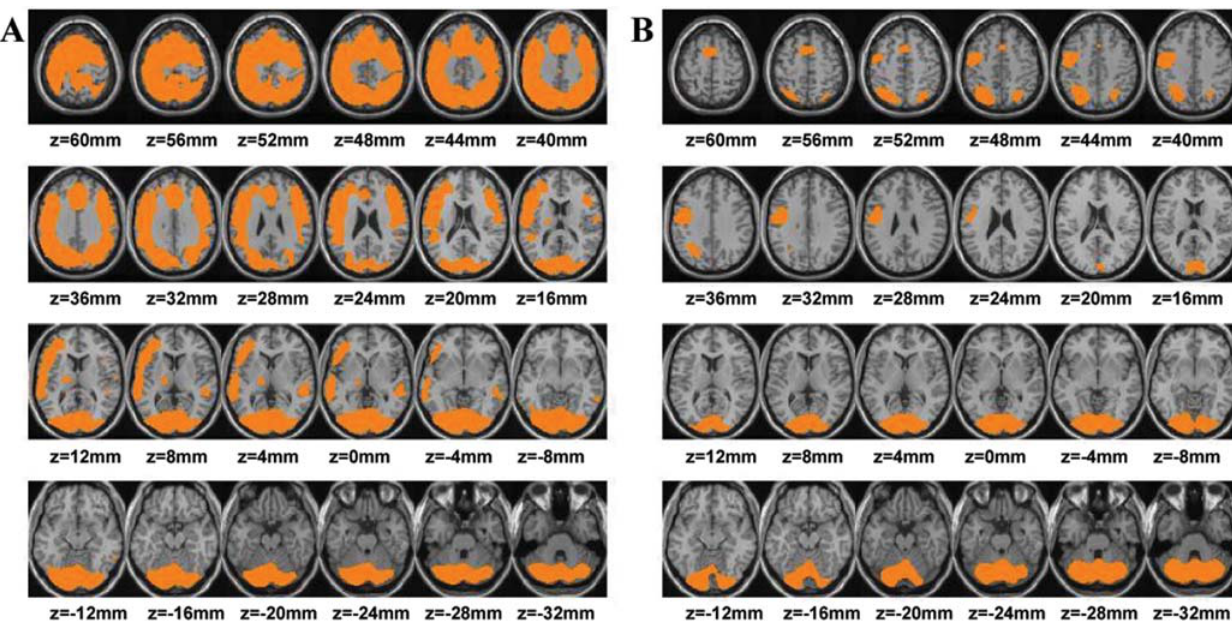
Figure 2. Brain activation with the task after placebo (PL) and after methylphenidate (MP). A . SPM results showing the areas that had increases in metabolism for the cognitive task with placebo versus the control conditions; B. SPM results showing the areas that had increases in metabolism for the cognitive task with MP versus the control conditions. Comparisons correspond to paired t tests (p , 0.001 uncorrected . 100 pixels). None of the brain regions had higher metabolism for the control condition (neutral non-task with placebo) than for the cognitive task conditions.